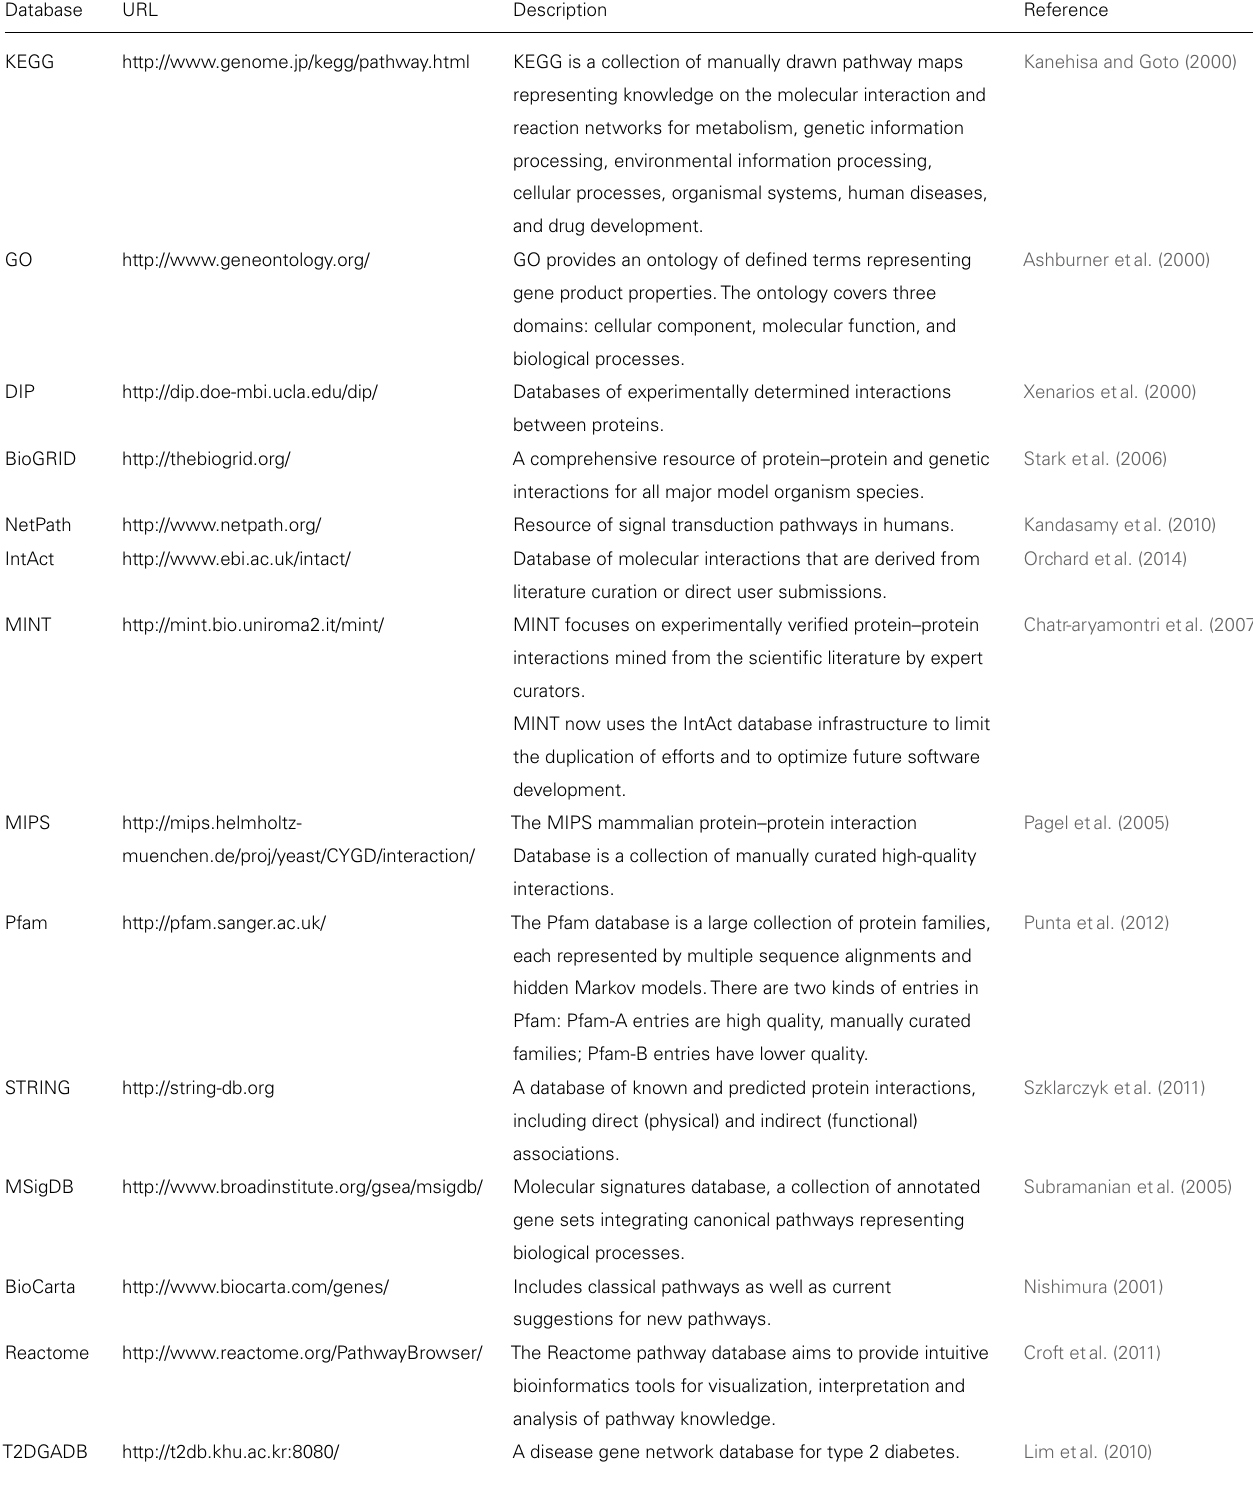
Table 1 | Biological information databases on gene ontology annotation, gene–gene interactions, pathways, disease related gene networks and systems.